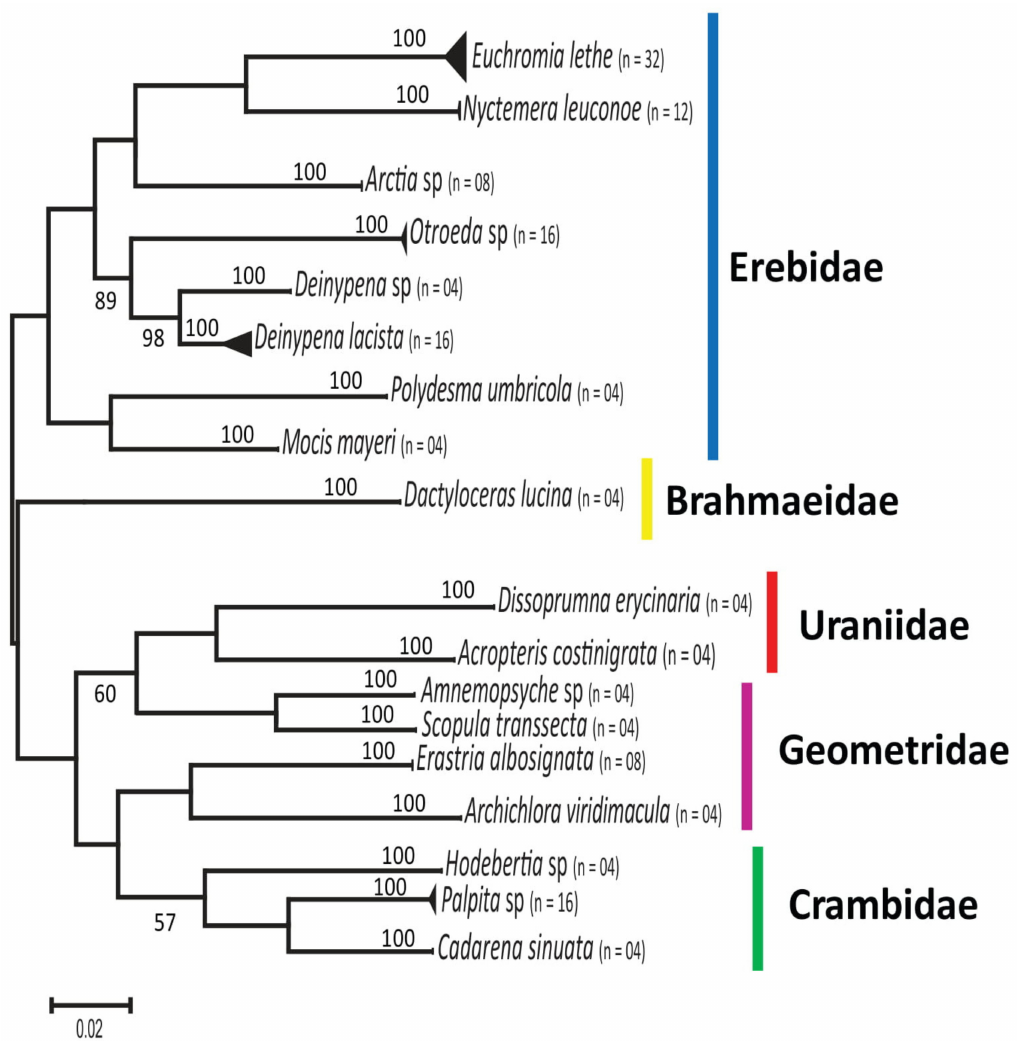
Figure 2. The unrooted Maximum Likelihood tree based on 152 mitochondrial Cytochrome C oxidase I ( COI ) sequences of moths from